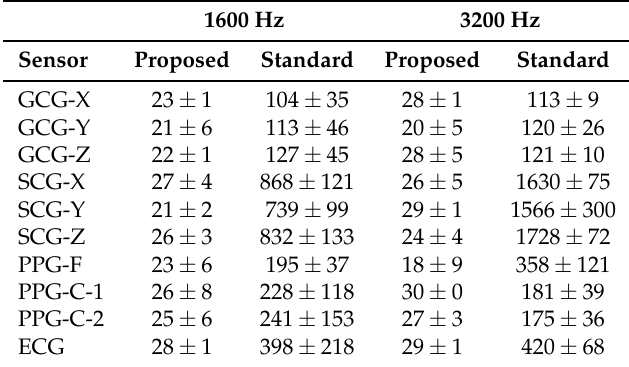
Table 1. Compression table size.